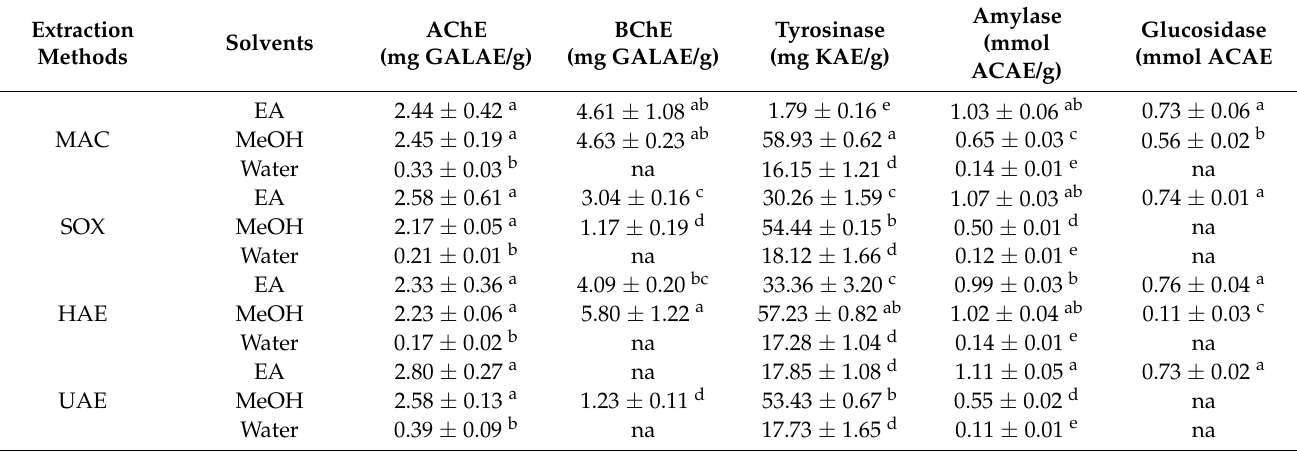
Table 4. Enzyme inhibitory effects of the tested extracts.